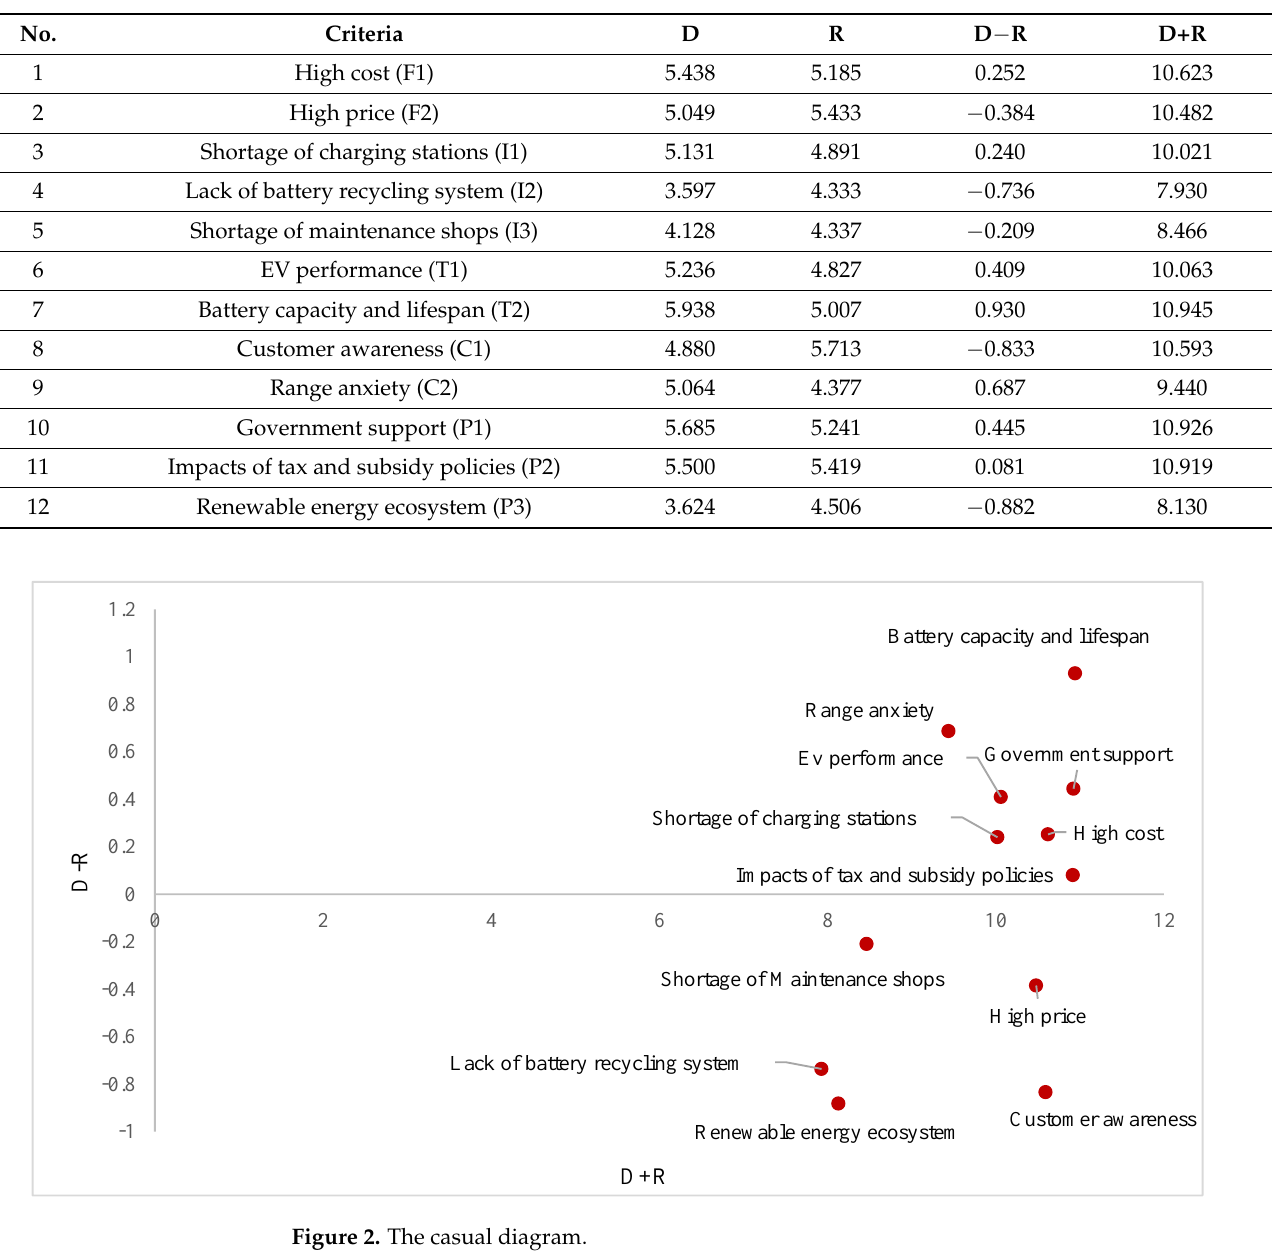
Table 6. Final results of DEMATEL analysis.